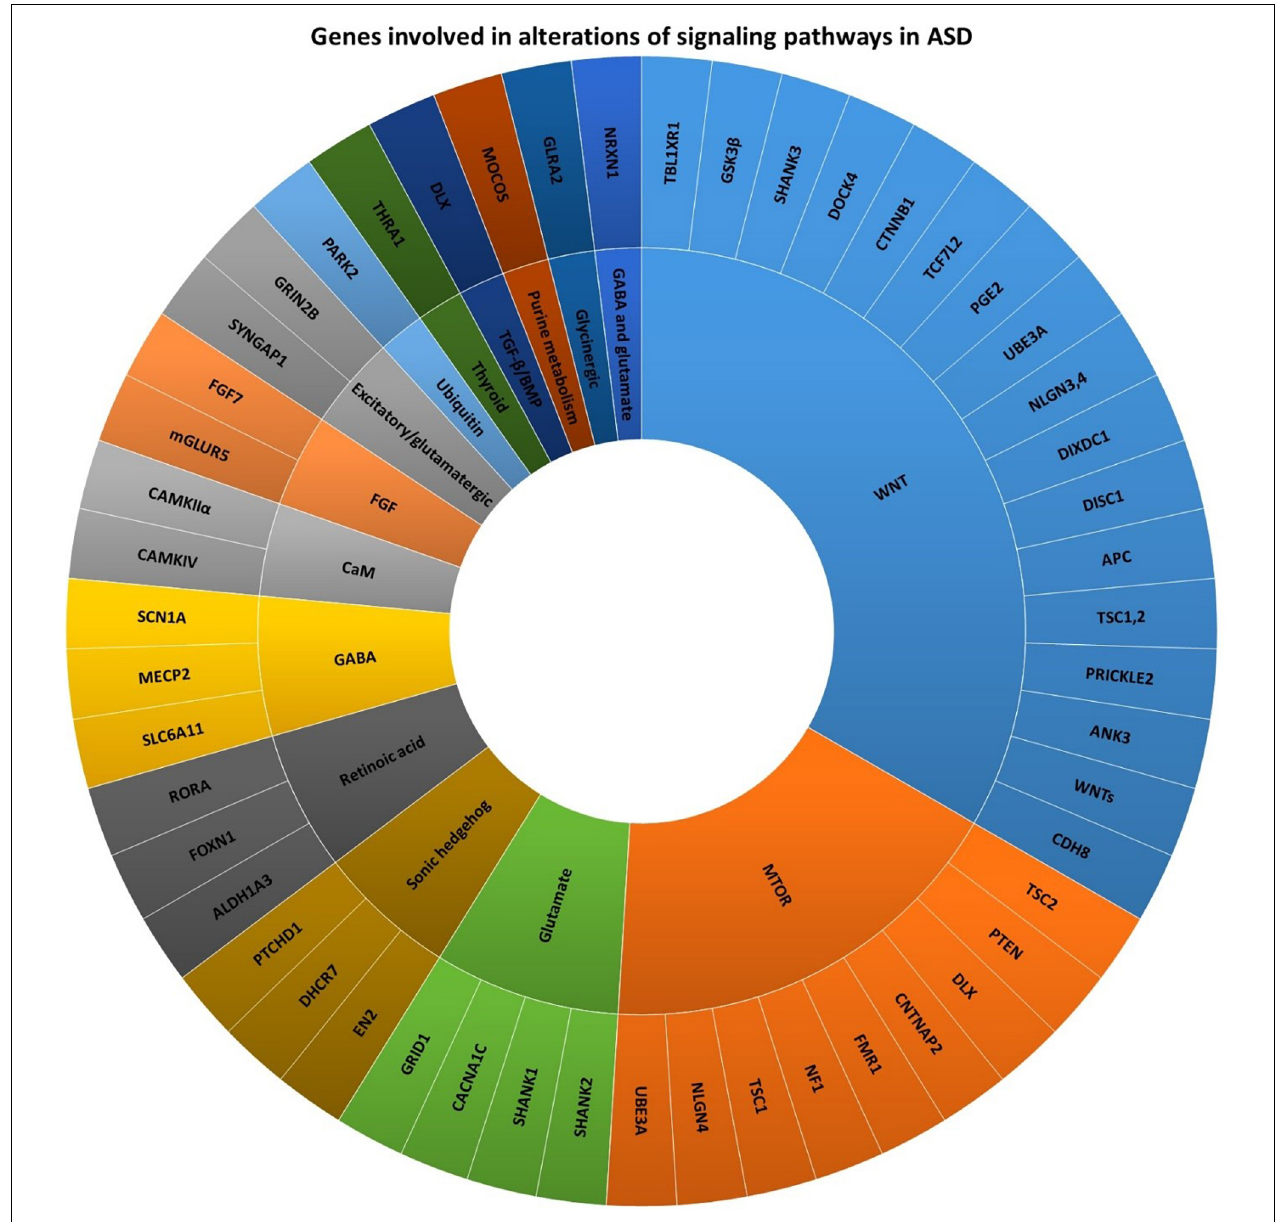
FIGURE 1 | Genes involved in alterations of signaling pathways in ASD (26,